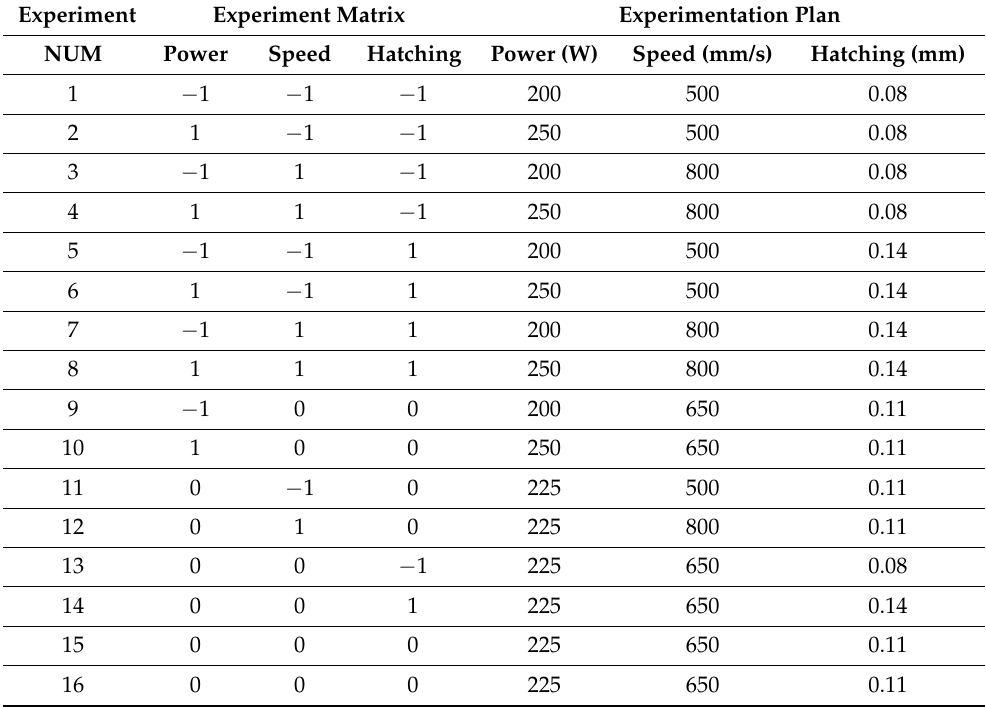
Table 3. Proposed design of